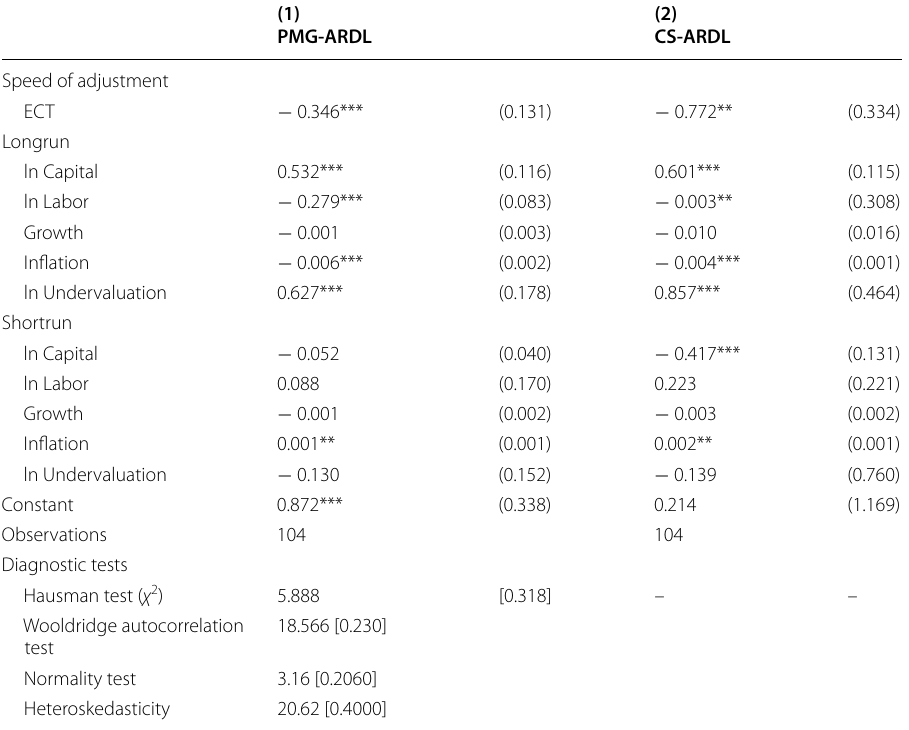
Model (1) is the baseline model. The Hausman test was carried out to choose between Mean Group ARDL and PMG-ARDL, and the latter was preferred. Long-run and shortrun coefficients for PMG-ARDL (1 0 0 0 0) with lags selected based on SIC; Standard errors in